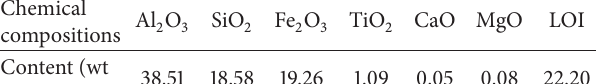
Table 2: Effect of leaching time and leaching temperature on extraction of Al 2 O 3 and Fe 2 O 3 .